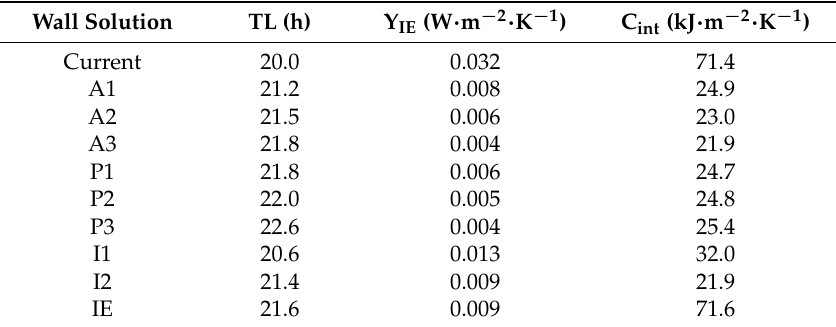
Table 3. Dynamic thermal properties for all the proposed wall